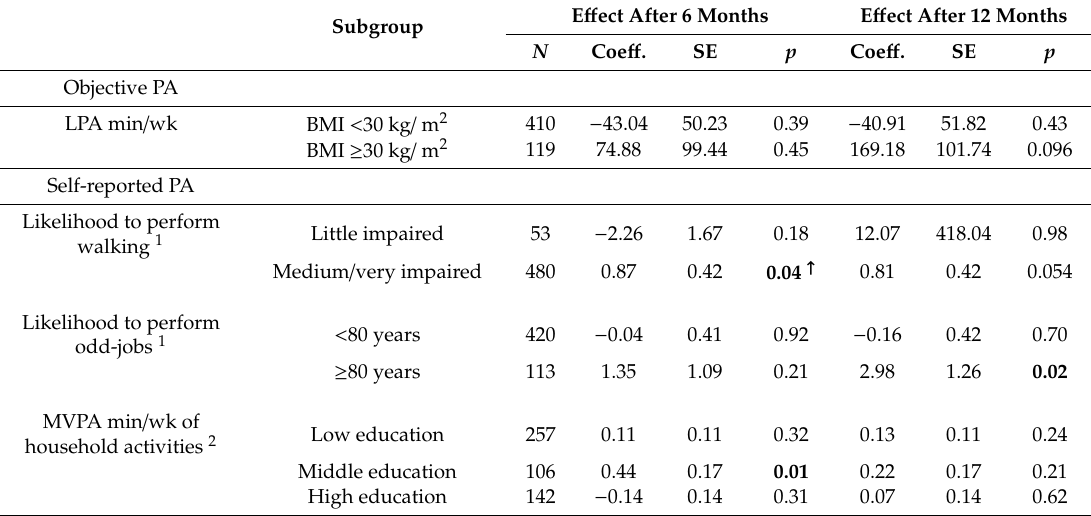
Table 4. Moderation of intervention e ff ects (Group × Time interaction) on PA outcomes for 6 and 12 months follow-up in subgroups